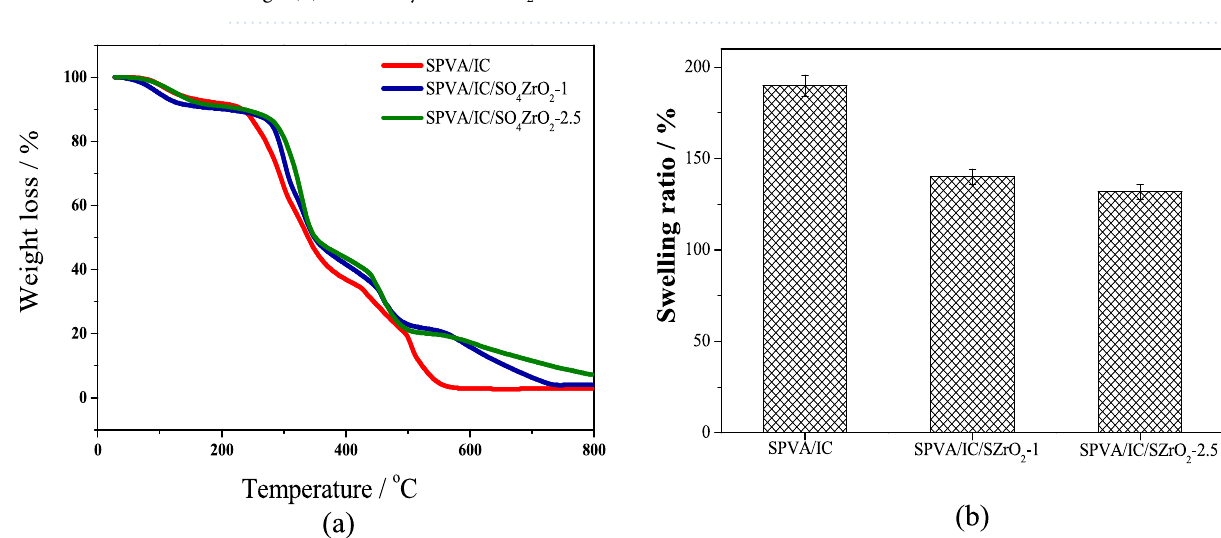
Figure 3. ( a ) TGA curves and ( b ) time dependent swelling response of SPVA/IC and SPVA/IC/SZrO 2 nanocomposite